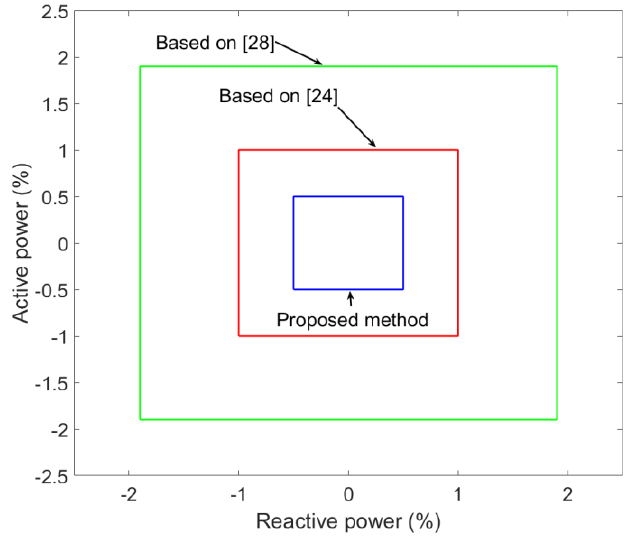
Figure 16. Non-detection zone (NDZ) of the proposed islanding detection technique.